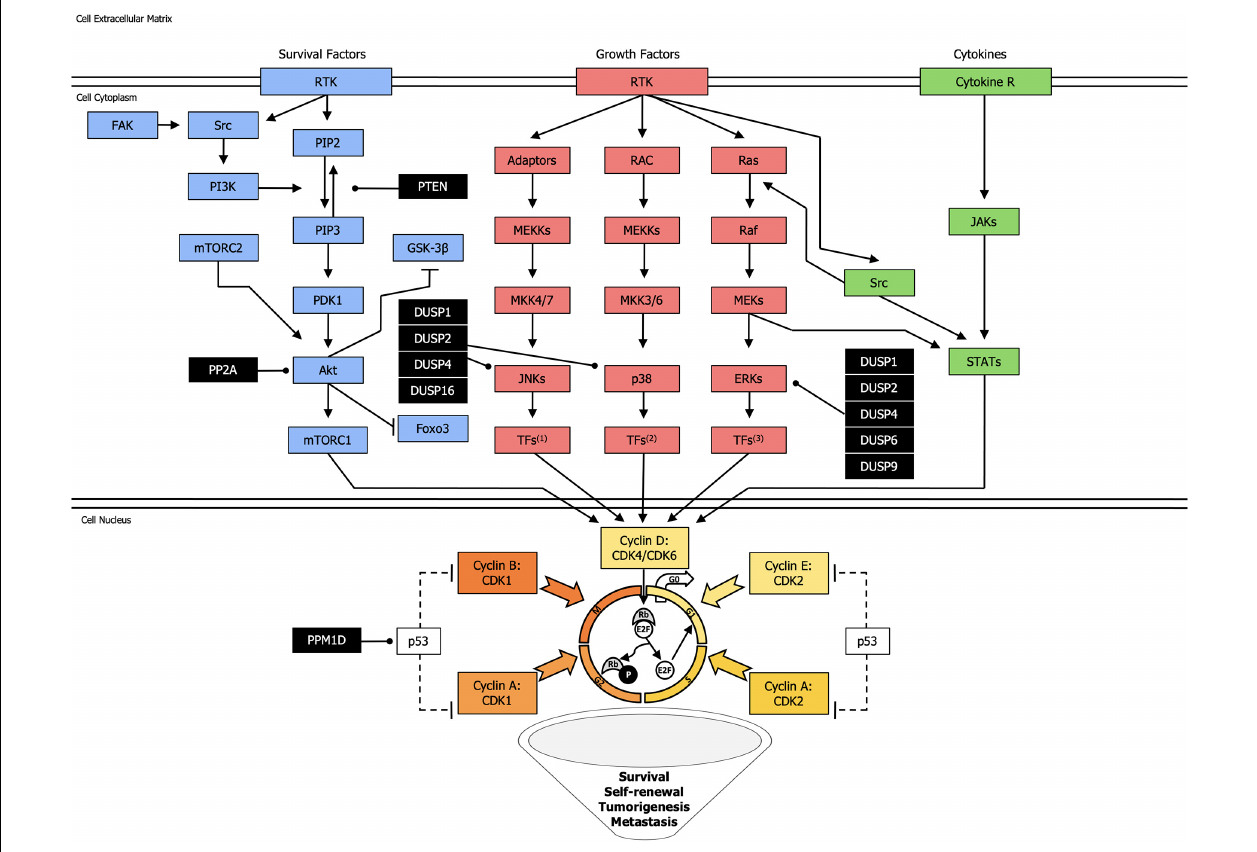
FIGURE 1 | Landscape of the most common kinases and phosphatases network in cancer stem cells. Kinase activating phosphorylation is shown with arrowed lines, inhibitory phosphorylation or non-phosphorylation is indicated with blocked lines, and dephosphorylation, exerted by phosphatases (black squares), is displayed with round-ended lines. Dotted lines represent indirect effect. TFs 1 : Transcription Factors (Jun, ATF2, RNPK, p53, NFAT4, Shc); TFs 2 : Transcription Factors (CHOP, ATF2, MNK, MSK, MEF2, Elk-1); TFs 3 : Transcription Factors (Elk-1, Ets-2, RSK, MNK, MSK,